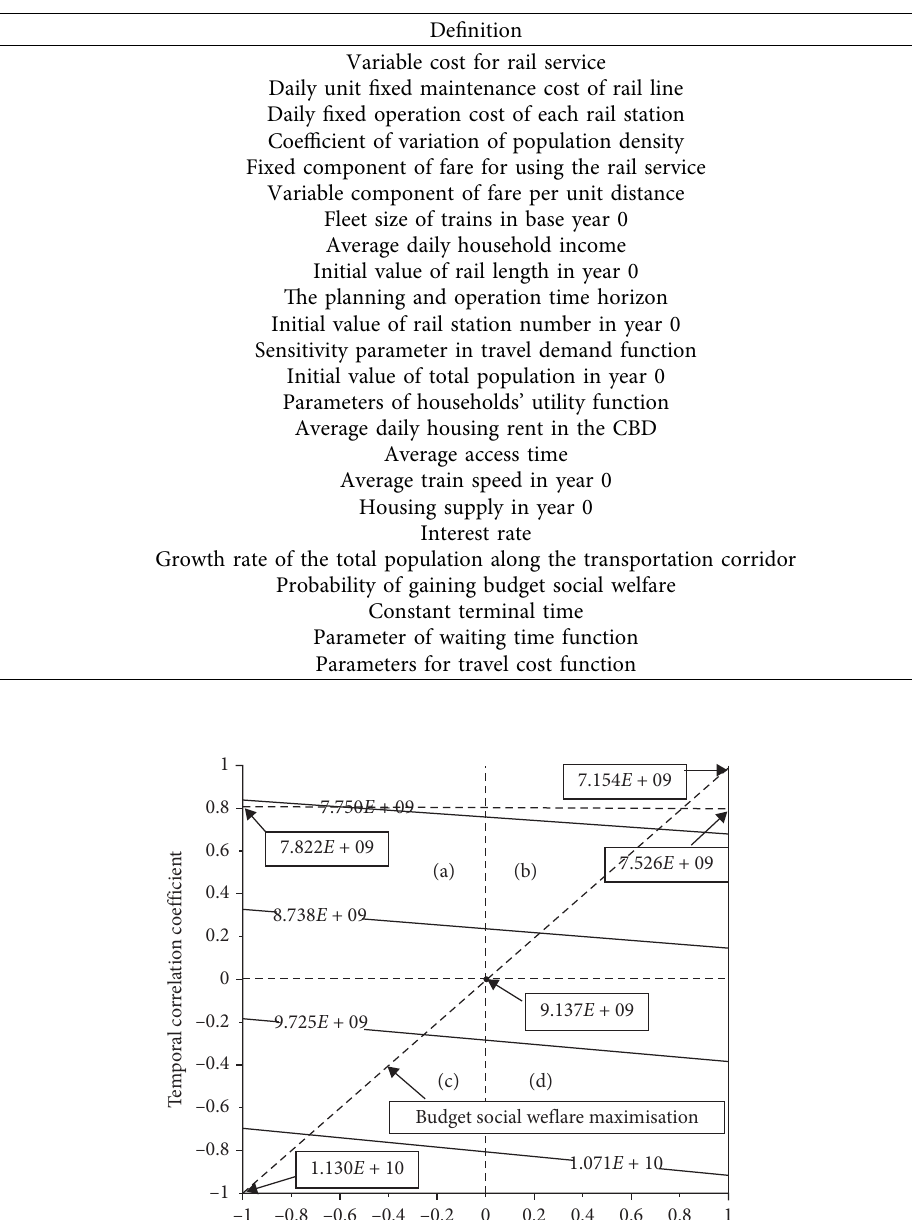
Table 1: Parameters.